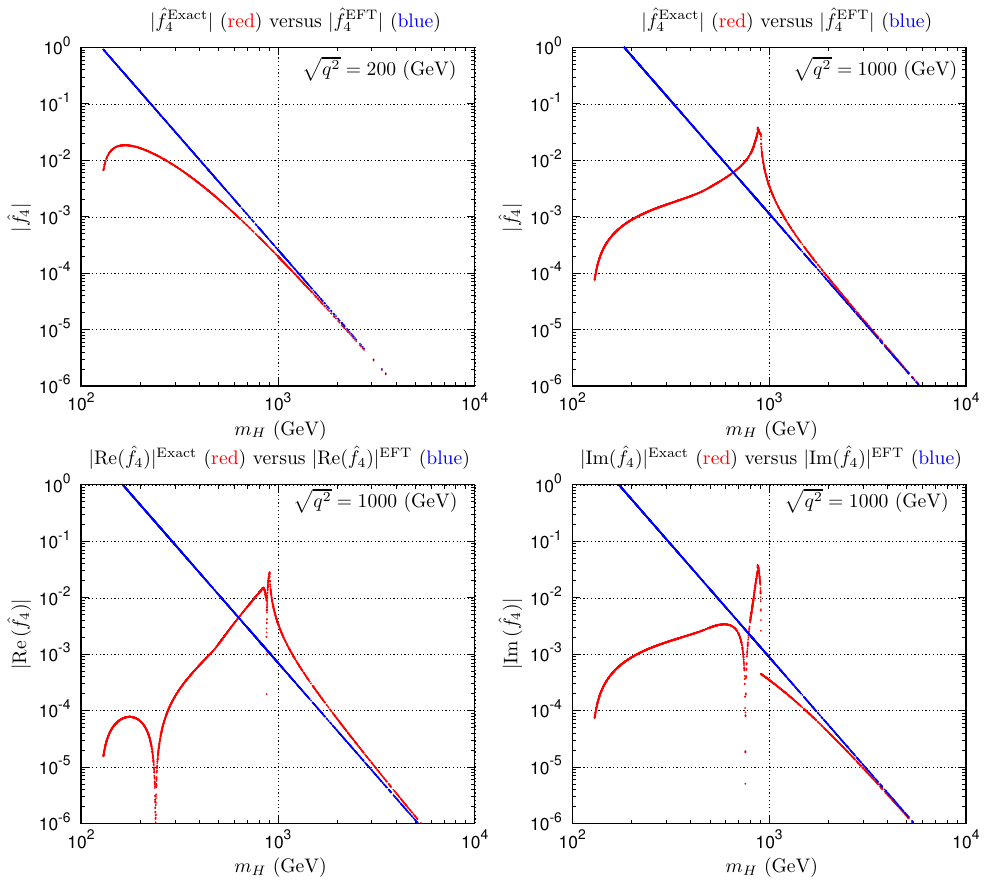
Figure 7 . Red: the normalized form factor ^ f Z on the second neutral Higgs mass m H for two values of separately the real and imaginary parts (for heaviest neutral Higgs mass is assumed to be the matched SMEFT (cf. eq.